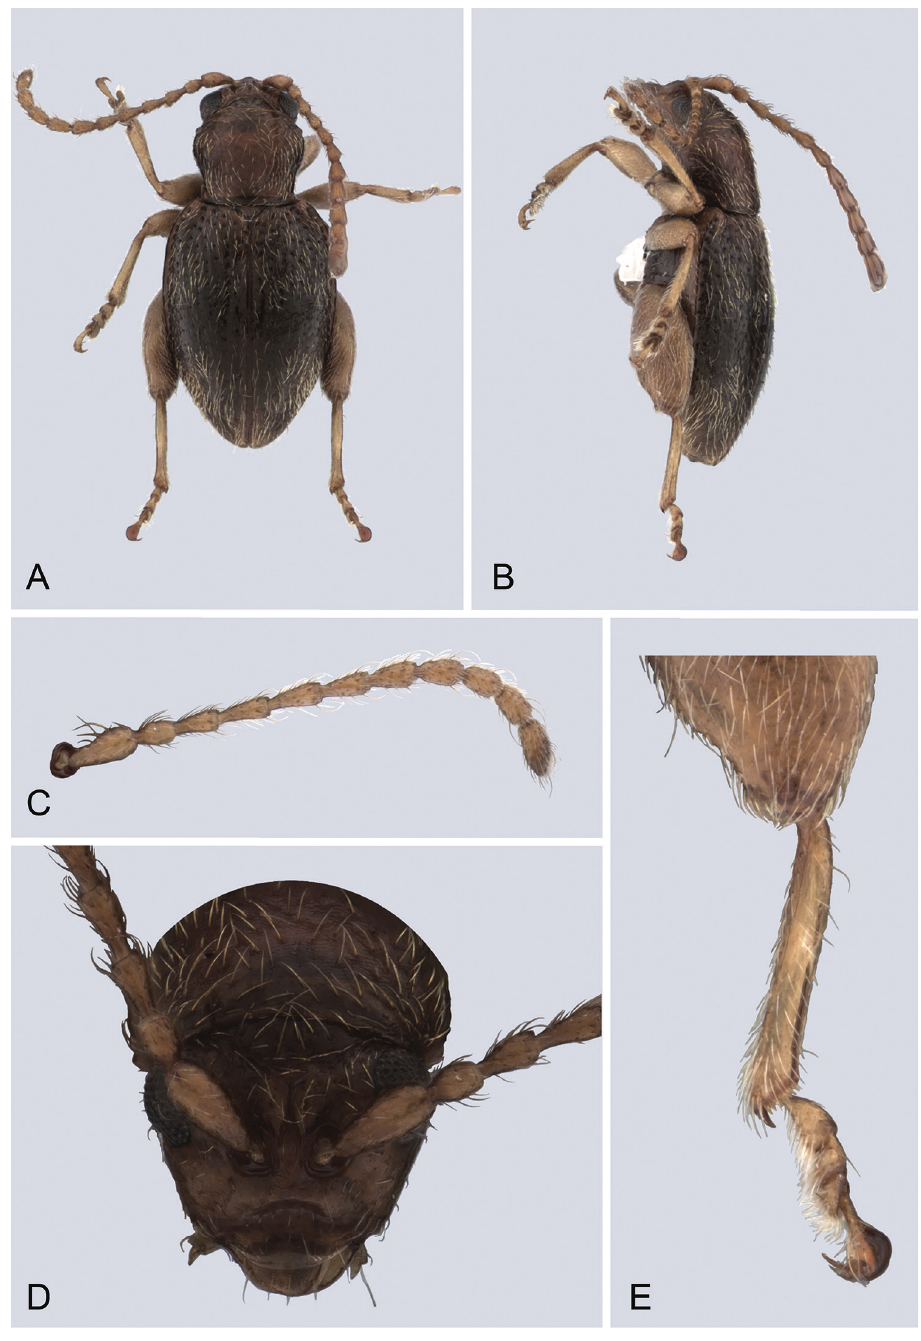
Figure 34. Andersonoplatus saviniae . A Habitus dorsal B Habitus lateral C Antenna D Head, frontal view E Hind